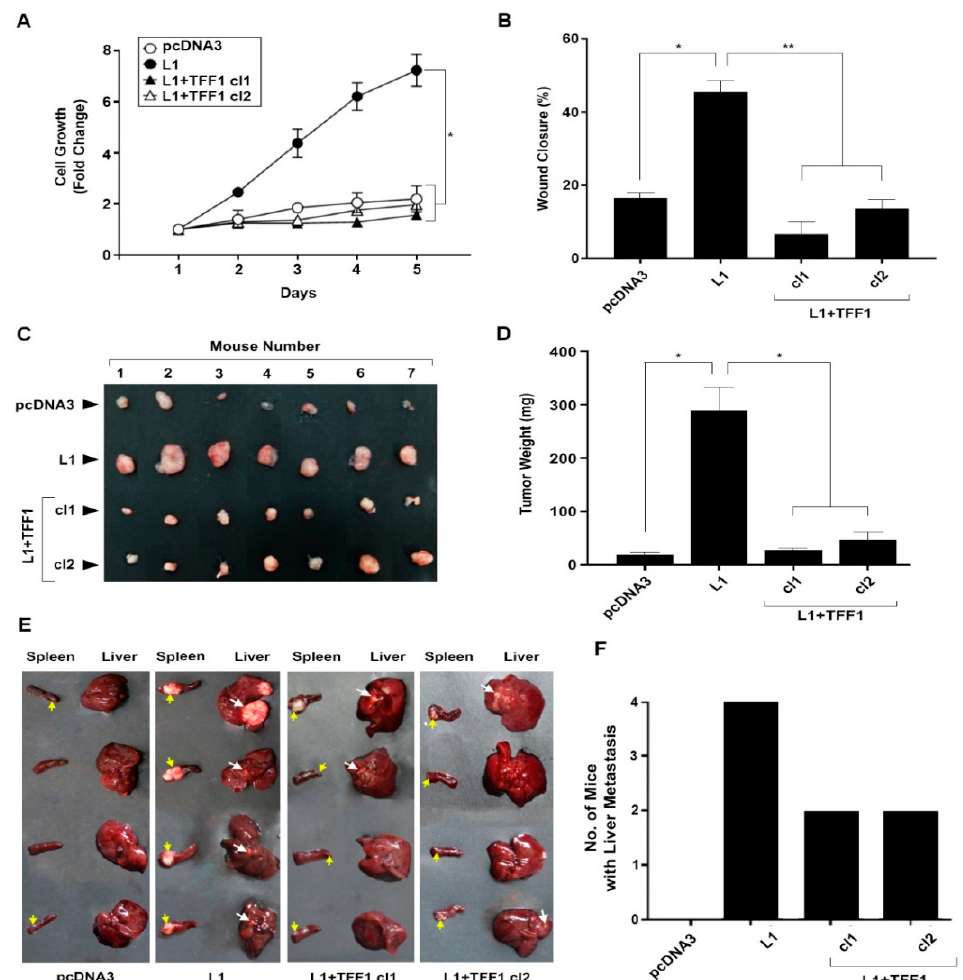
Figure 3. Suppression of the L1-mediated increase in cell proliferation, motility, tumorigenicity, and metastasis by the expression of TFF1. ( A ) The proliferation of pcDNA3-transfected control LS 174T CRC cells (pcDNA3), L1-overexpressing CRC cells (L1), and L1 + TFF1-overexpressing CRC cell clones (L1 + TFF1 cl1 and cl2) in the presence of 0.5% serum was determined over five days; ( B ) the motility of the CRC cell clones described in ( A ) was determined by the “scratch wound” closure method 24 hrs after introducing the “wound”, as percent wound closure; ( C , D ) the tumorigenic ability of the CRC cell clones described in ( A ) was determined by subcutaneous injection of the CRC cell clones described in ( A ); two weeks after injection, the tumors were excised, photographed ( C ), and their weight determined ( D ); ( E , F ) the metastatic capacity of the cell lines described in ( A ) was determined by injecting each cell clone into groups of 4 mice and determining the development of liver metastases after six weeks. The yellow arrows point to tumor growth at the site of injection in the spleen, while the white arrows point to metastatic growth in the liver of the corresponding mice. * p < 0.05, ** p < 0.01.